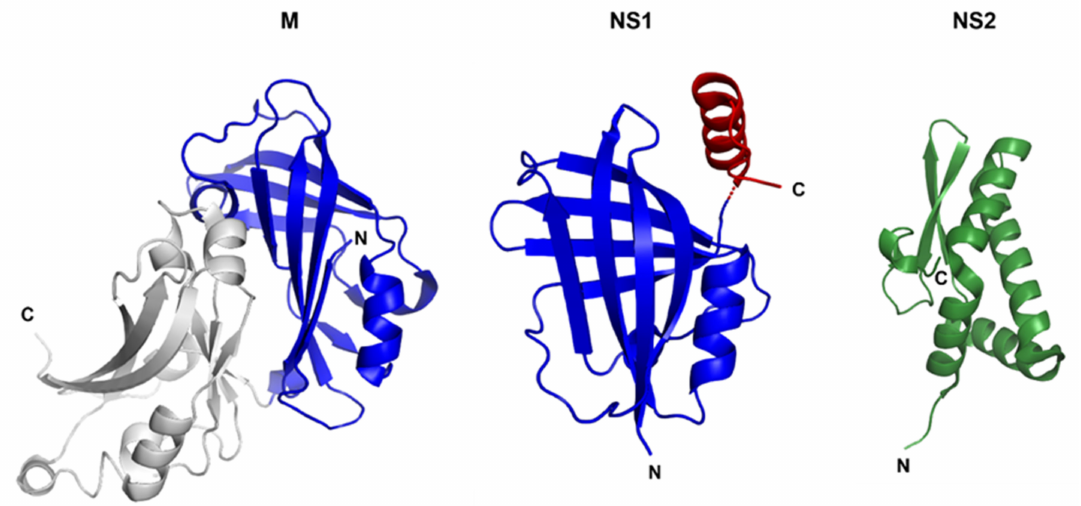
Figure 3. Cartoon representations of the crystal structure of RSV M, NS1, and NS2. The N-terminal domain of RSV M shows structural similarities to NS1 (blue). The α 3 helix of NS1 (red) is absent in M and is critical for IFN inhibition. NS2 (green) consists of a mixed alpha–beta fold that is unique. (PDB code for M: 4V23; PDB code for NS1: 5VJ2; PDB code for NS2: 7LDK). Figure prepared with PyMOL (http://www.pymol.org/ (accessed on 12 January